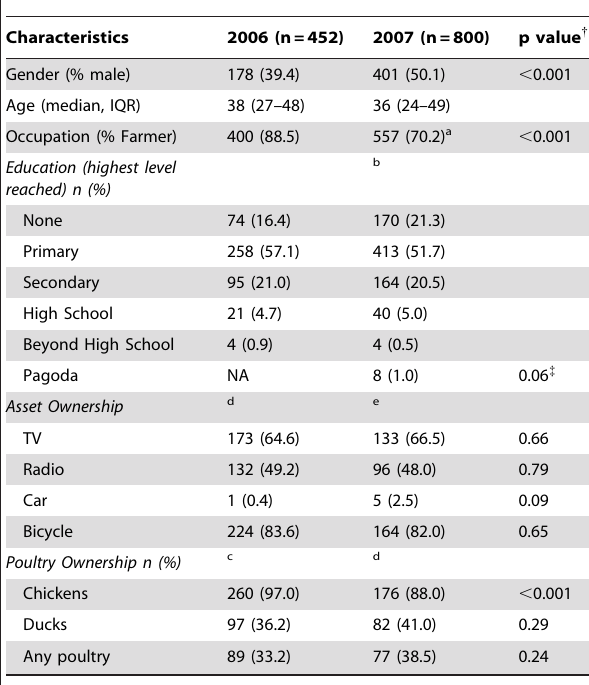
Table 1. Demographic characteristics of subjects . 15